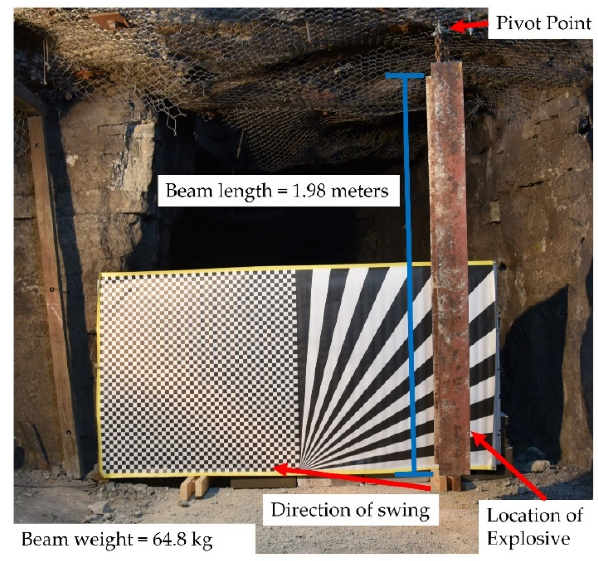
Figure 1. Experimental test set-up in an underground limestone test arena.